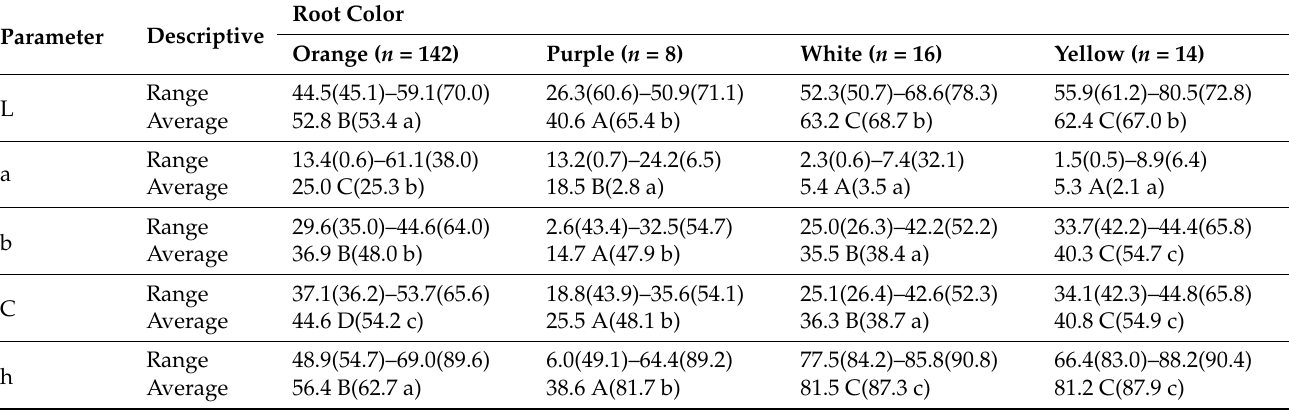
Table 3. Variation in outer and inner color of the carrot root ( n = 180).